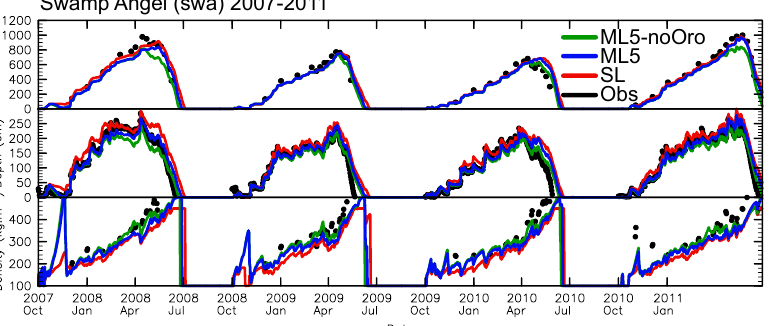
Figure 16. Time series of snow water equivalent (SWE), snow Depth, and snow Density for Swamp Angel (swa) from observations (Obs, black dots) and the offline experiments using the single-layer (SL, red lines), multilayer (ML5, blue lines), and multilayer without the snow depth-dependent snow layer thickness described in Section 3.2 (ML-noOro, green lines). The latter configuration corresponds to a simulation with the same vertical discretization of the snowpack as used by Arduini et al.